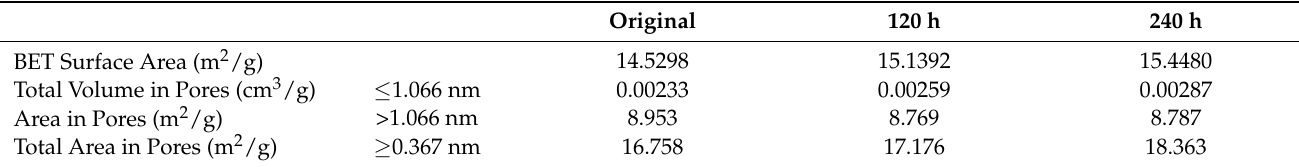
Table 4. CO 2 adsorption summarized report.